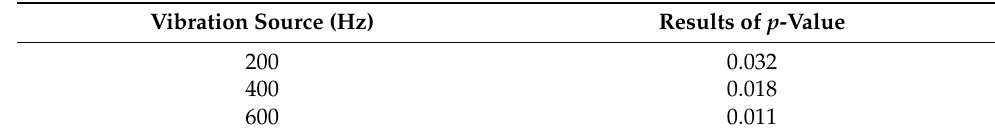
Table 1. The results of p -value according to induced